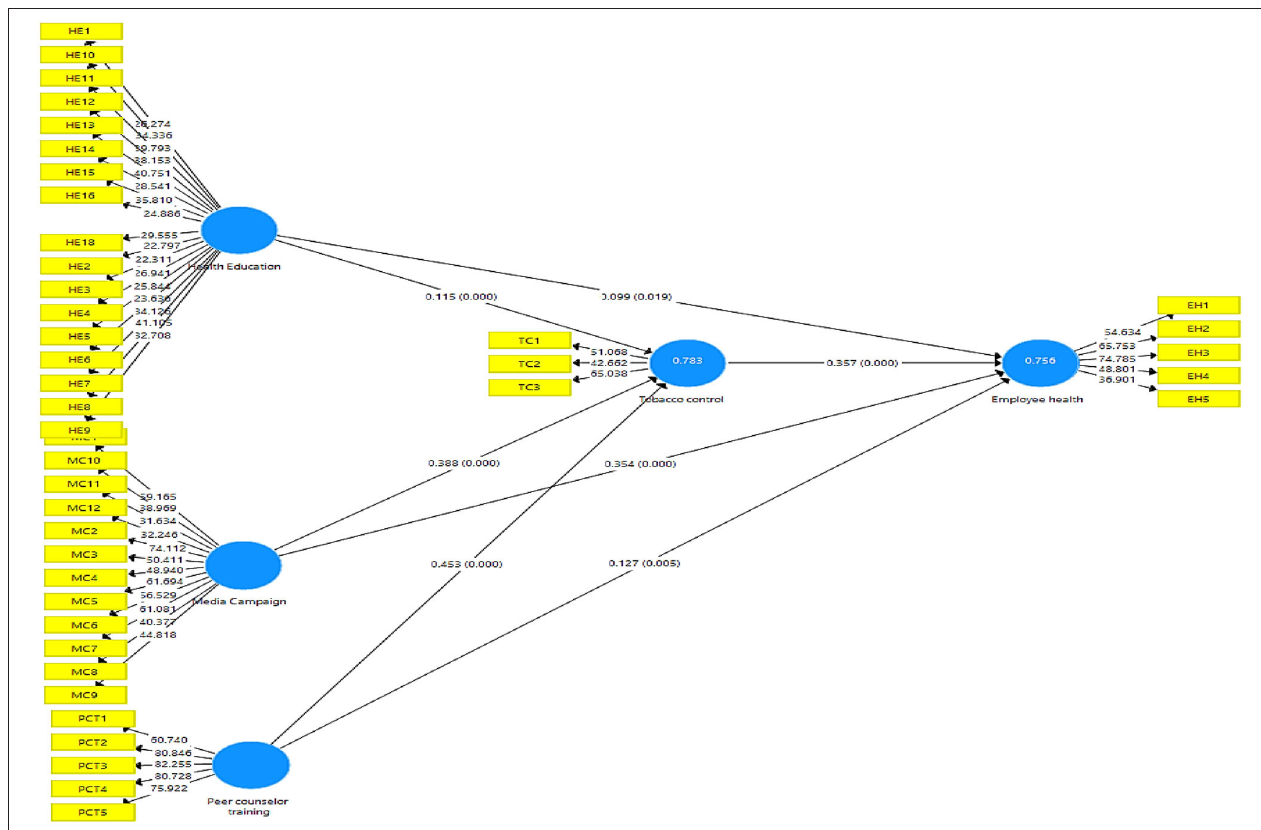
FIGURE 3 | Structural analysis.